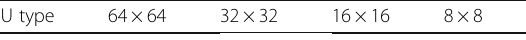
Table 1 Most promising modes for different PU types PU type